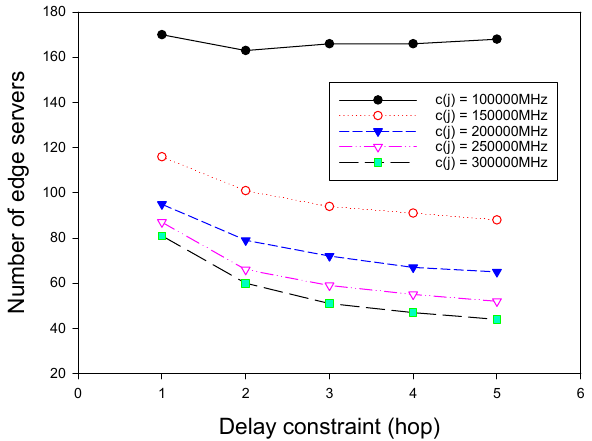
Figure 11. The impact of capacity on the number of edge